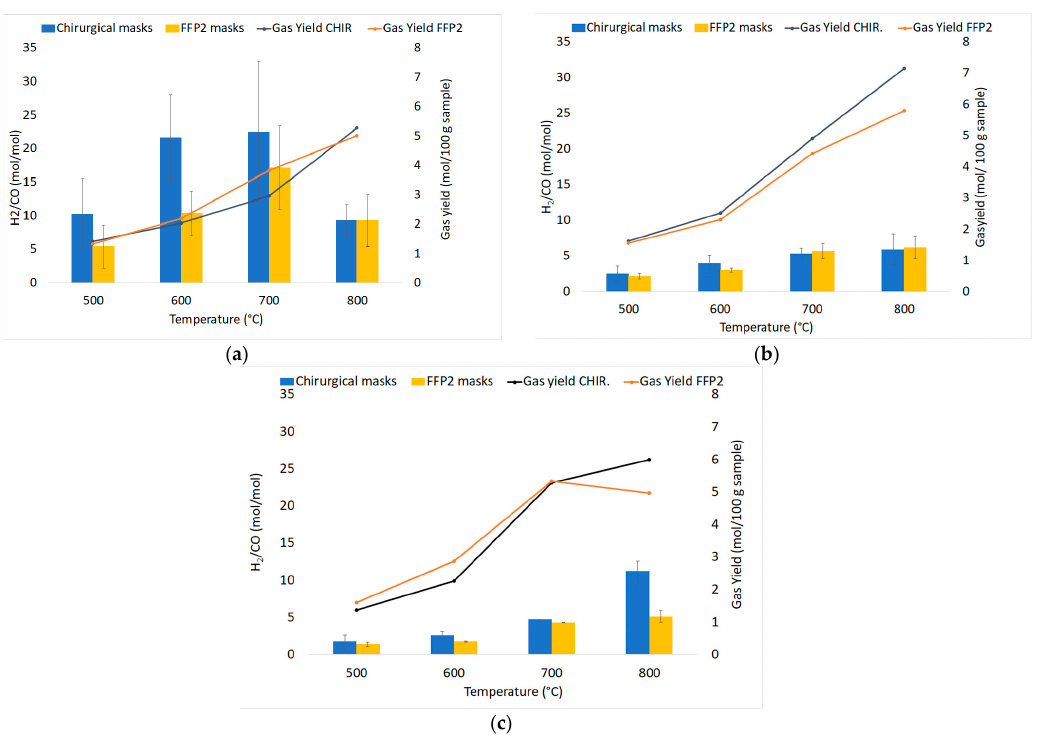
Figure 7. Experimental results of devolatilization tests as a function of temperature: H 2 /CO ratio values in nitrogen ( a ), diluted air ( b ), and diluted air using wet pellets ( c ). Energies 2022 , 15 , x FOR PEER REVIEW